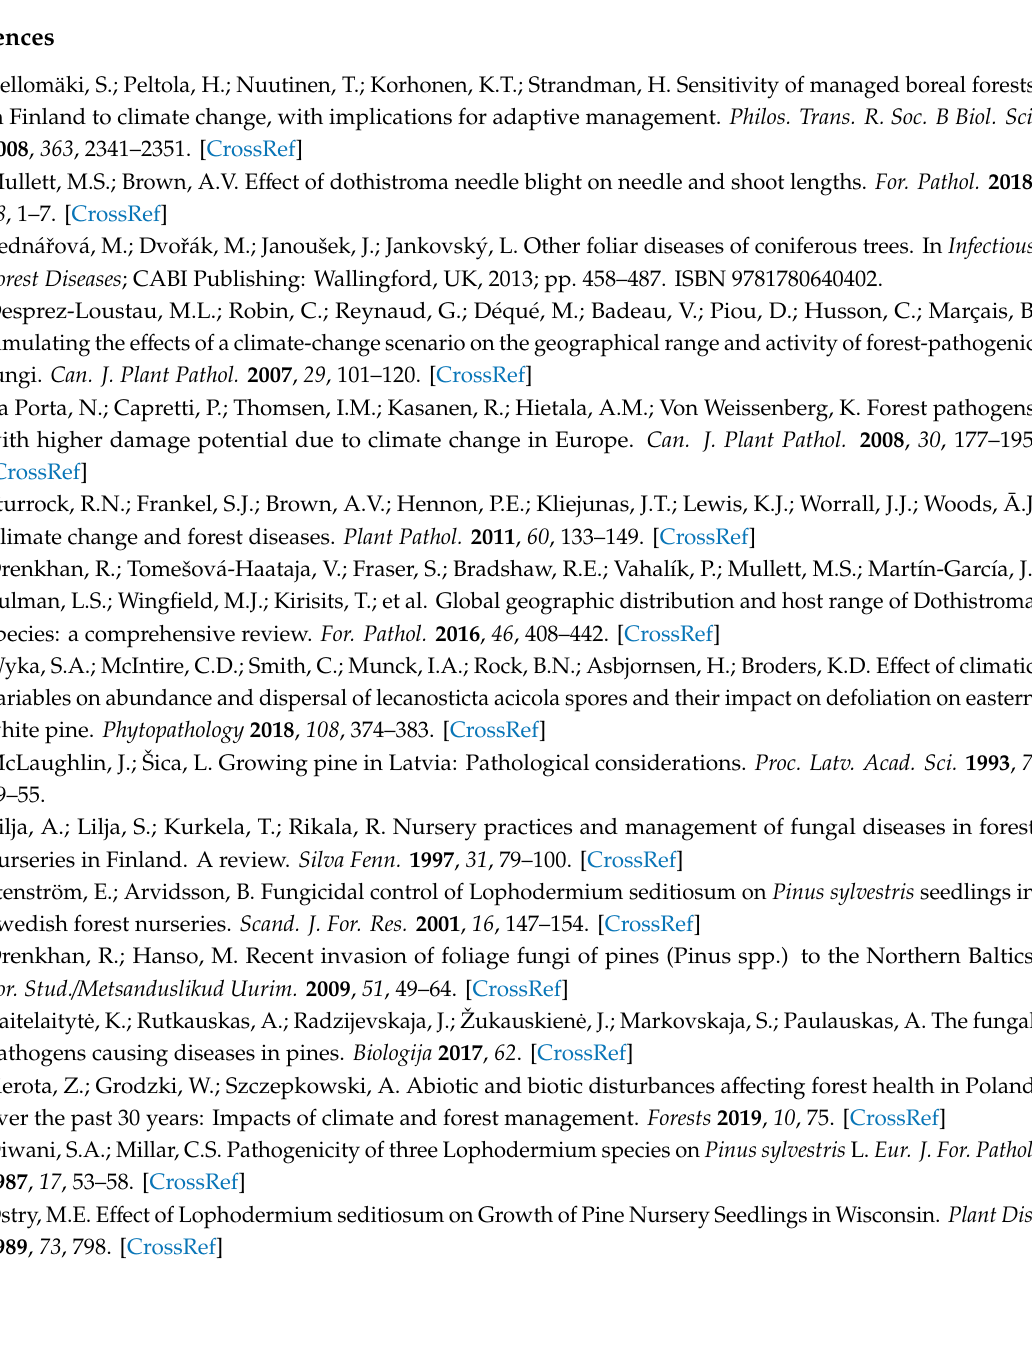
Supplement 1: Applied growth modelling system, Table S1: Commercial thinning schedule (removed volume, m 3 ha − 1 ) in simulated stands with di ff erent initial densities and thinning criteria, Table S2: Forest management operations and their costs used in the simulations, Table S3: Assortment prices at di ff erent price levels, Table S4: Equal annual annuity (EAA) for di ff erent Lophodermium needle cast damage levels in simulated management scenarios of various initial density at the age of 17 years, and di ff erent thinning regimes